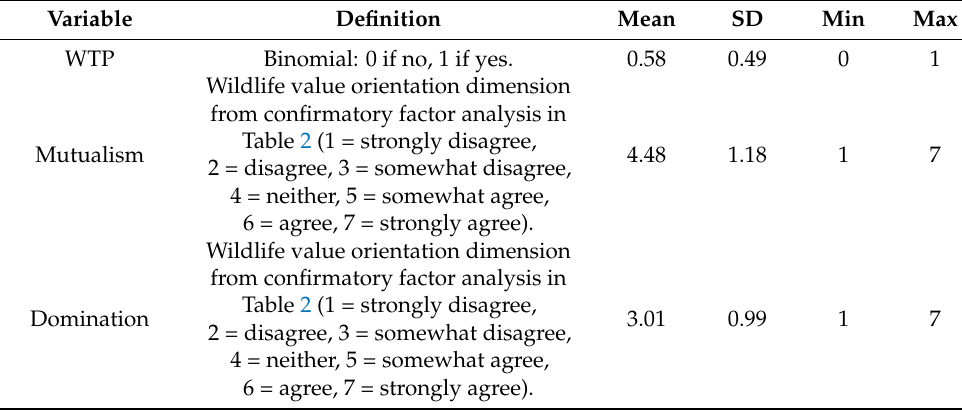
Table 1. Willingness to pay (WTP) and predictor